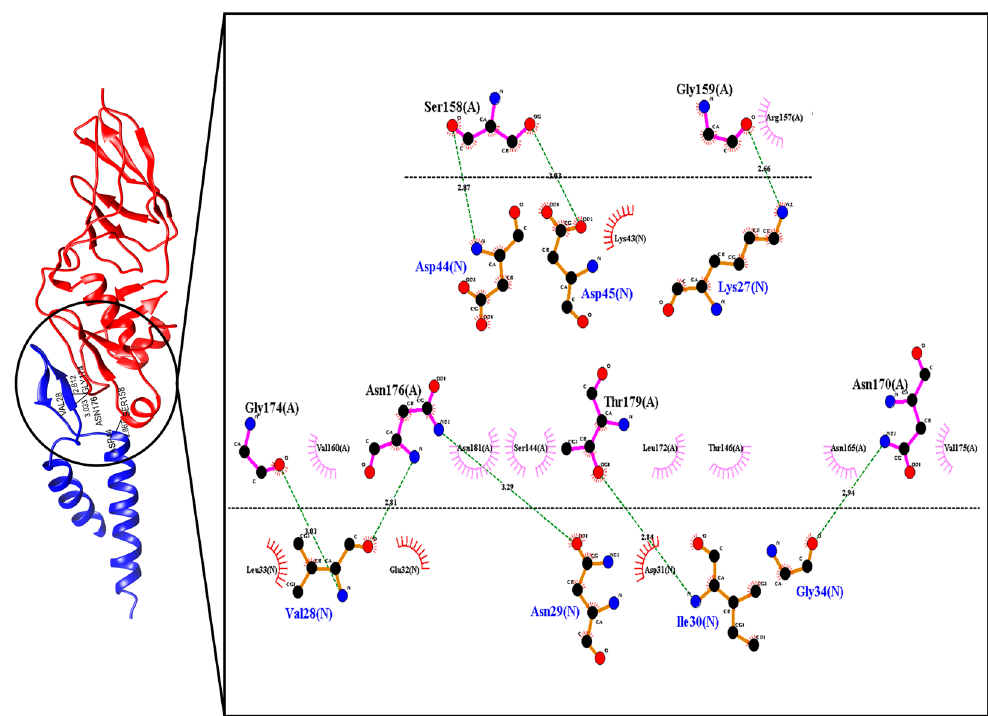
Figure 1. Crystal structure of the interaction between TIR proteins (N-Blue chain) and Intimin (A-Red chain), obtained from the PDB 2ZQK model.